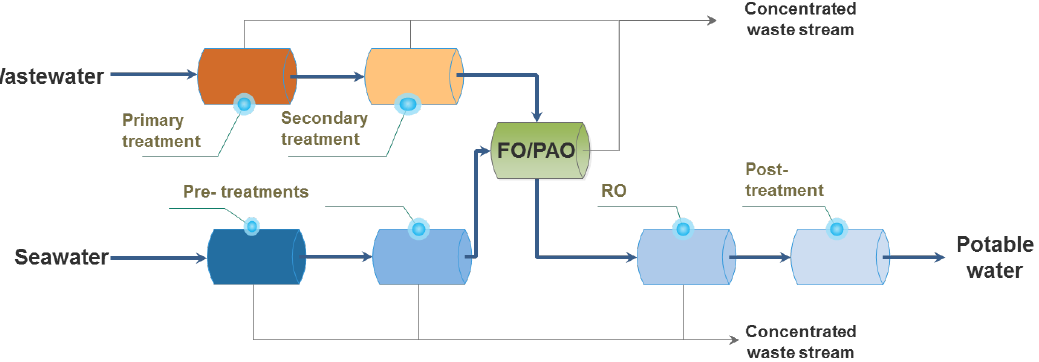
Figure 3. Proposed integration of FO in desalination process as FO-RO hybrid (adapted from [55]).